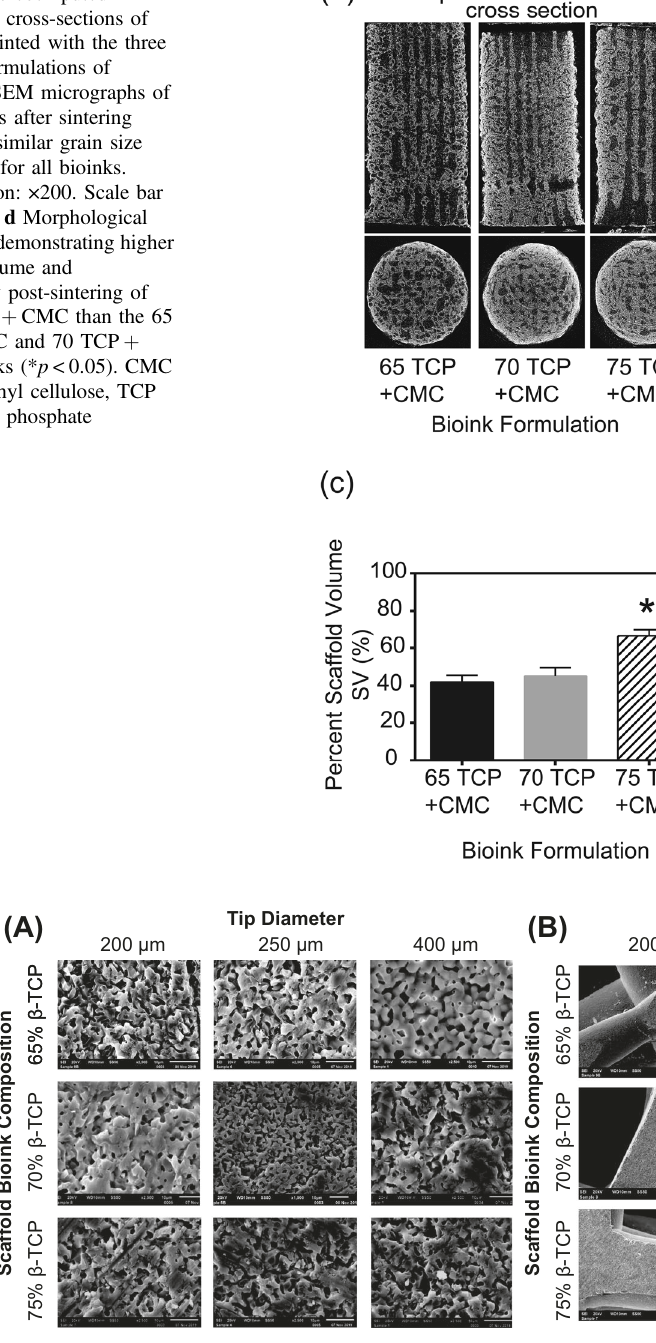
and the pure β -TCP powder (Fig. 4b, black dashed line) were similar, suggesting similar crystalline structure. In contrast, the green body bioink XRD spectrum was mostly fl at, typical of amorphous solids (Fig. 4b, black solid line).